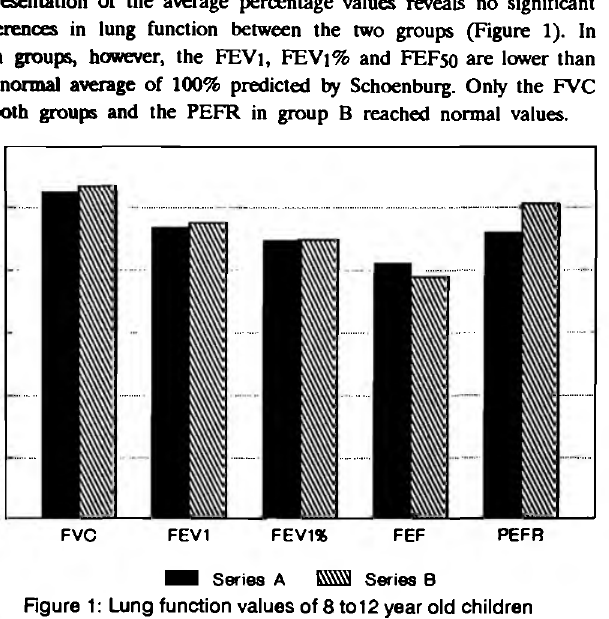
Figure 1: Lung function values of 8 to12 year old